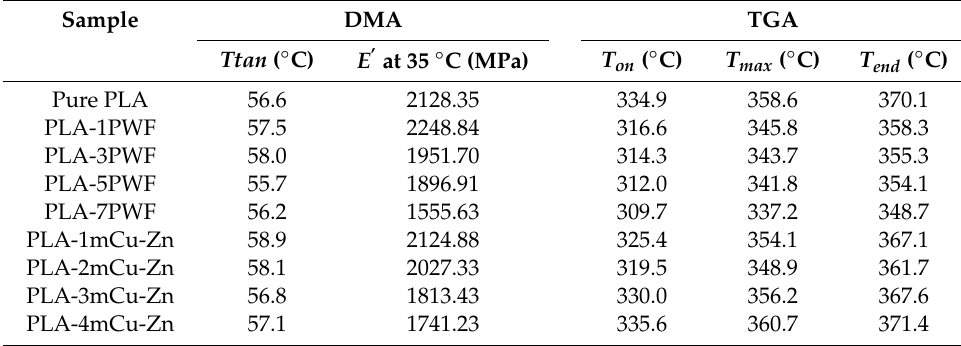
Table 3. DMA and TGA data of PWF / PLA and mCu-Zn / PWF / PLA